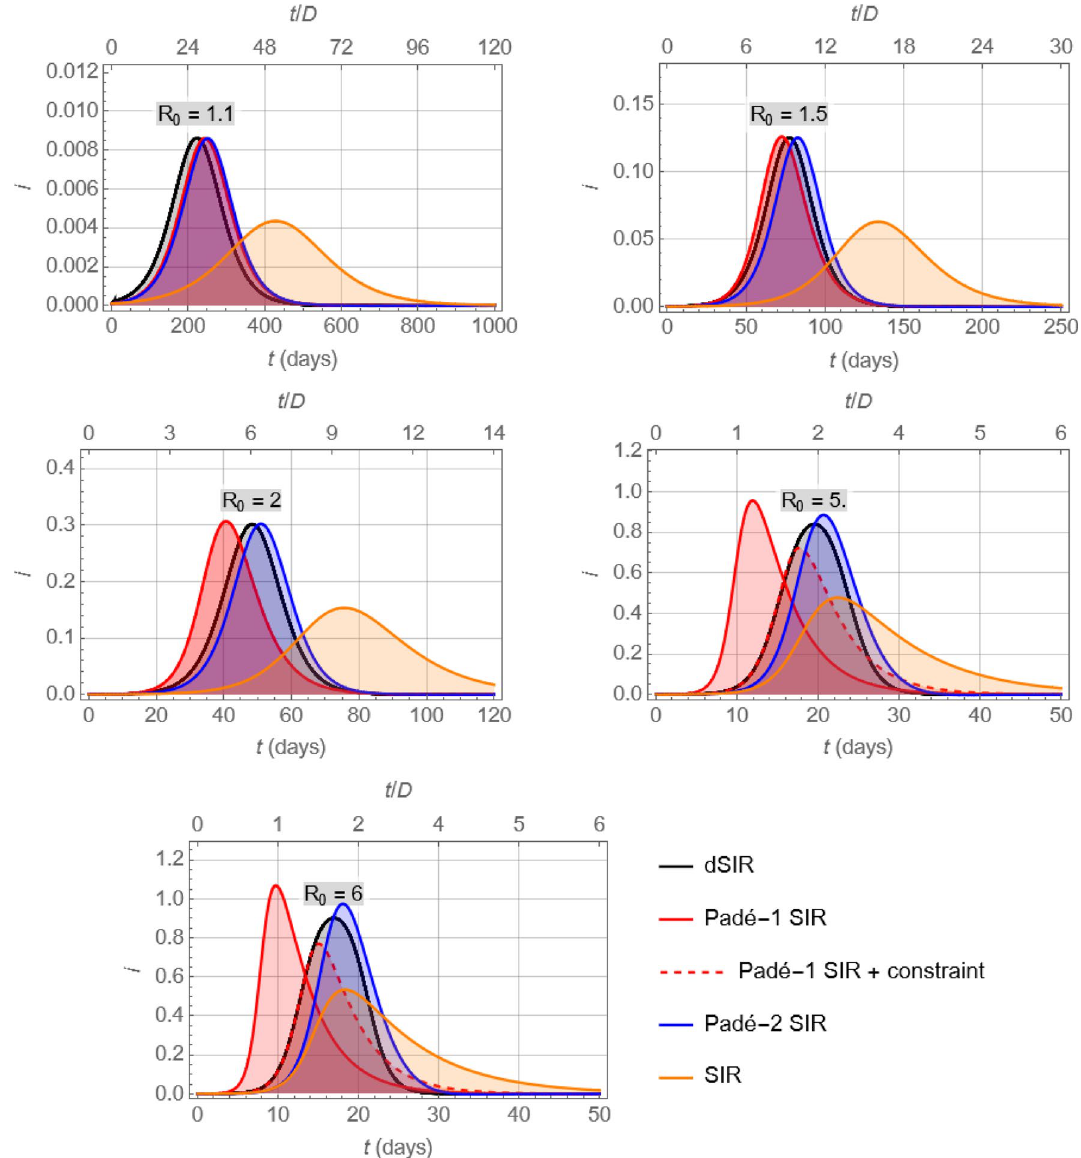
Figure 5. Comparison of the infectious fraction profiles, i ( t ) , resulting from the dSIR, Padé SIR (first- and second-order), and SIR models for different values of R 0 . Note that for relatively moderate values of R 0 both Padé SIR models approximate the dSIR model well, whereas for large values of R 0 the Padé-2 SIR remains a usable approximator while the Padé-1 SIR model approaches its usefulness